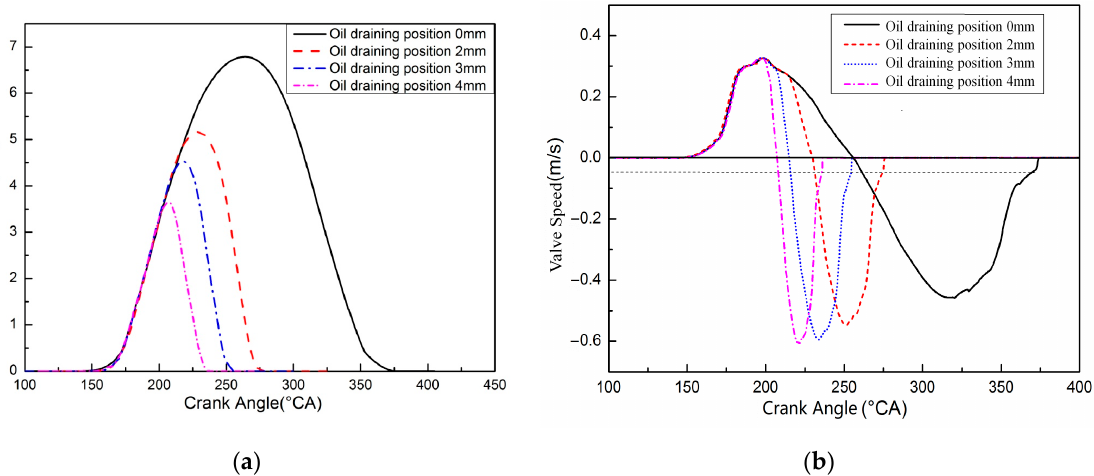
Figure 7. ( a ) Valve lift curves under different times of early ‐ releasing oil; ( b ) Valve velocity curve under different times of early ‐ releasing oil.